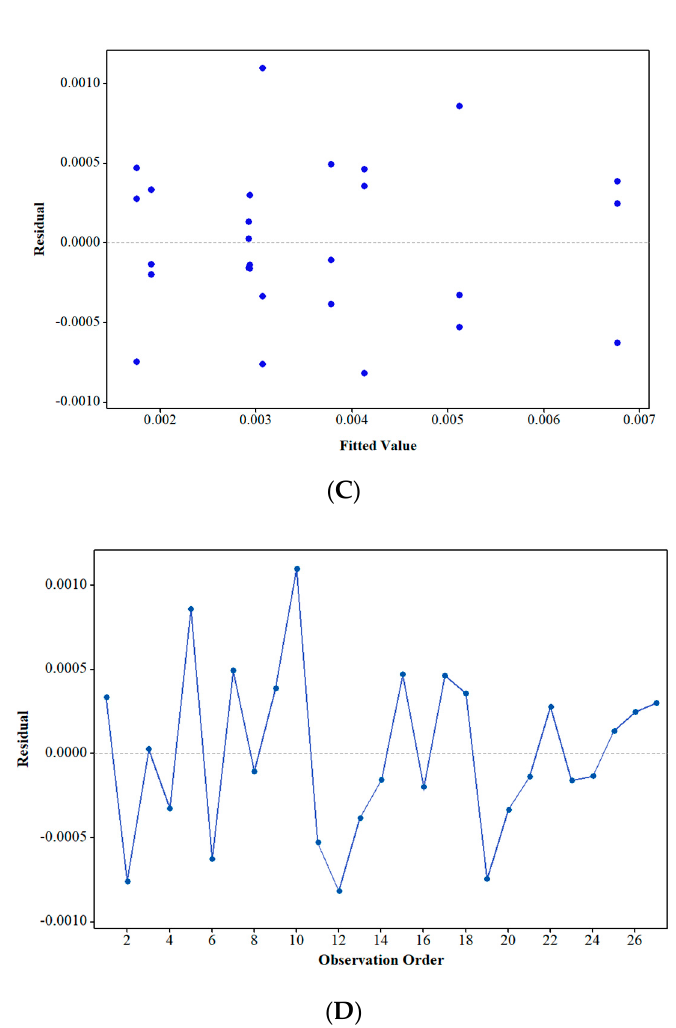
Figure 11. Statistical diagnostic tests of nitrate removal: normal probability plot of residuals ( A ), residual vs. frequency ( B ), residuals vs. fitted values ( C ) and residuals vs. observation order ( D ).